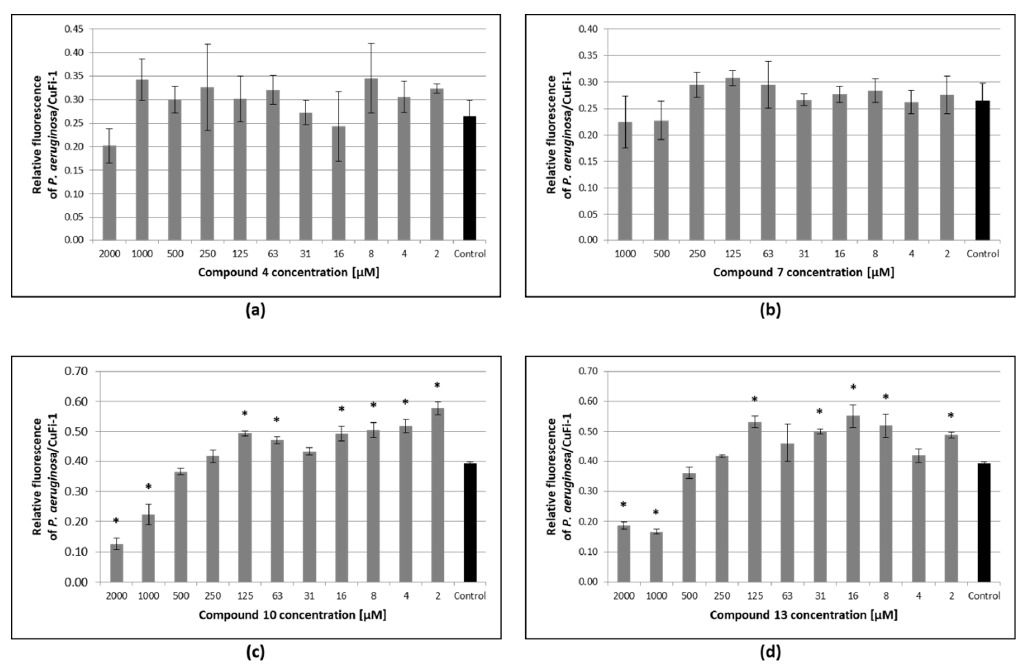
Figure 6. Adherence of P. aeruginosa to human bronchial epithelial cells (CuFi-1) in the presence of the tested compounds. Monolayers of PKH67-labeled CuFi-1 cells were incubated for 2 h with suspensions containing PKH26-labeled P. aeruginosa and tested compounds (grey bars) or PBS as a control (black bars). After discarding of non-adhered bacteria, the relative fluorescence of adhered P. aeruginosa and CuFi-1 was quantified using Tecan Infinite M200 Pro. Results are expressed as a relative fluorescence ratio of P. aeruginosa /CuFi-1 plotted as a function of compounds concentrations. Plotted data are means ± SD of three independent incubations. * indicates significant difference ( p < 0.05; Dunnett test). ( a ) Results for compound 4 ; ( b ) Results for compound 7 ; ( c ) Results for compound 10 ; ( d ) Results for compound 13 .